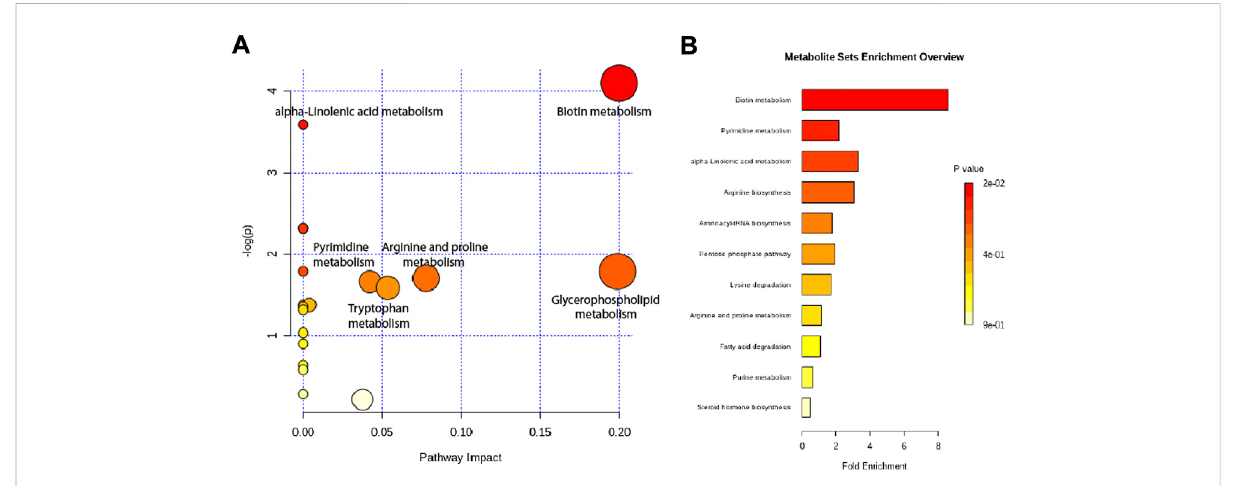
FIGURE 7 Metabolic pathway analysis of altered metabolites. (A) Pathways visualized as bubble plots. (B) Pathways visualized as enrichment